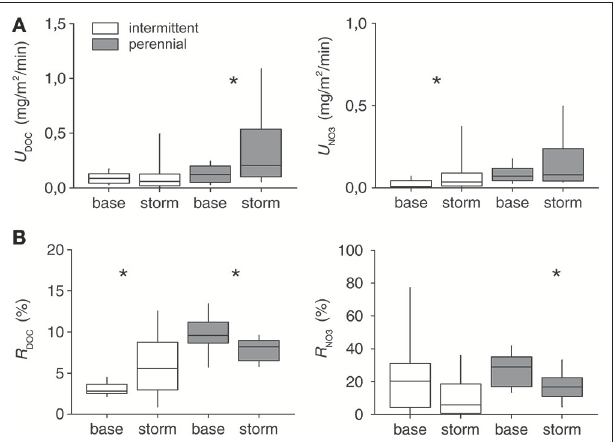
FIGURE 3 | Box-plots of (A) in-stream areal uptake rates ( U ) and (B) whole-reach retention ( R ) of dissolved organic carbon (DOC) and nitrate (NO − 3 ) for the intermittent and the perennial stream during base flow and storm flow conditions. Lines are medians, the extreme of the boxes are the 25th and 75th percentiles, and whiskers are the 10th and 90th percentiles. For each stream, asterisks (*) indicate statistically significant differences between base flow and storm flow conditions (Wilcoxon test, p < 0.05).